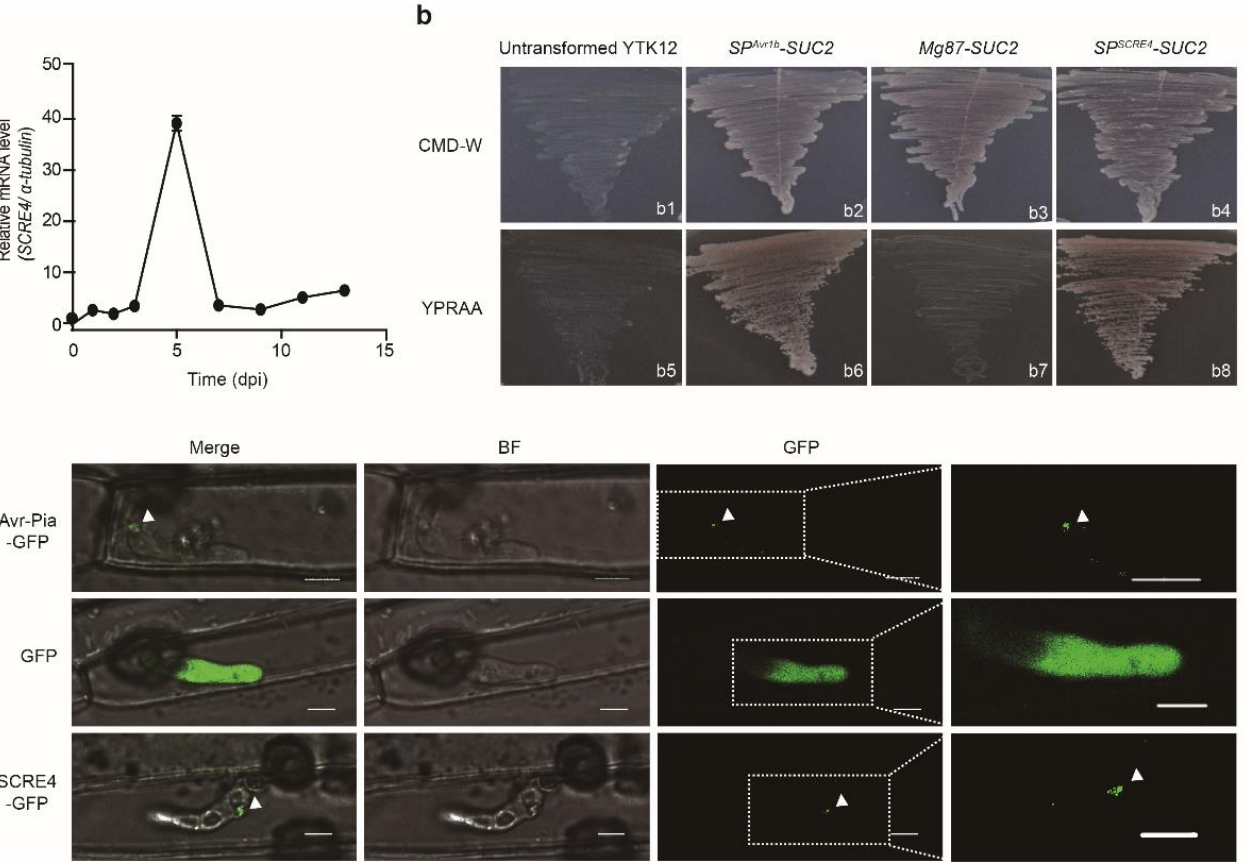
Figure 1. Identification of the secreted effector SCRE4 in U. virens . ( a ) Expression pattern of SCRE4 during U. virens infection. The expression of SCRE4 was detected in the inoculated panicles via quantitative RT-PCR at the indicated time points after the susceptible rice variety LYP9 was inoculated with U. virens . The α -tubulin gene was used as an internal reference. The representative data from three independent experiments are presented as mean ± standard error (SE) ( n = 3). ( b ) Functionality of the putative signal peptide of SCRE4 confirmed by the yeast secretion system. b1 – 4: untransformed YTK12, SP Avr1b -SUC2- , Mg87-SUC2- and SP SCRE4 -SUC2 -transformed YTK12 strains were cultured on CMD-W medium, respectively; b5 – 8: the above-mentioned strains were cultured on YPRAA medium with raffinose as sole carbon source, respectively. SP Avr1b -SUC2 , the signal peptide-encoding sequence of P. sojae Avr1b in fusion with the truncated SUC2 gene. Mg87-SUC2 , the N-terminal peptide-encoding sequence of non-secreted Mg87 in M. oryzae in fusion with the truncated SUC2 gene. SP SCRE4 -SUC2 , the putative signal peptide-encoding sequence of SCRE4 fused to the truncated SUC2 gene. ( c ) Green fluorescence from SCRE4 - GFP and Avr - Pia - GFP (a positive control) observed in BICs during M. oryzae infection. Leaf sheaths were inoculated with M. oryzae strains transformed with pYF11- ProRP27:SCRE4-GFP , pYF11- ProRP27:Avr-Pia-GFP or pYF11- ProRP27:GFP . The images were captured by confocal microscopy at 30 h after inoculation. BICs are indicated by white triangles. GFP, green fluorescent protein; BF, bright field; Merge, the overlay of GFP and BF images; Images on the right are enlarged from the blocks in broken squares in the GFP panels. Scale bar = 5 μm.